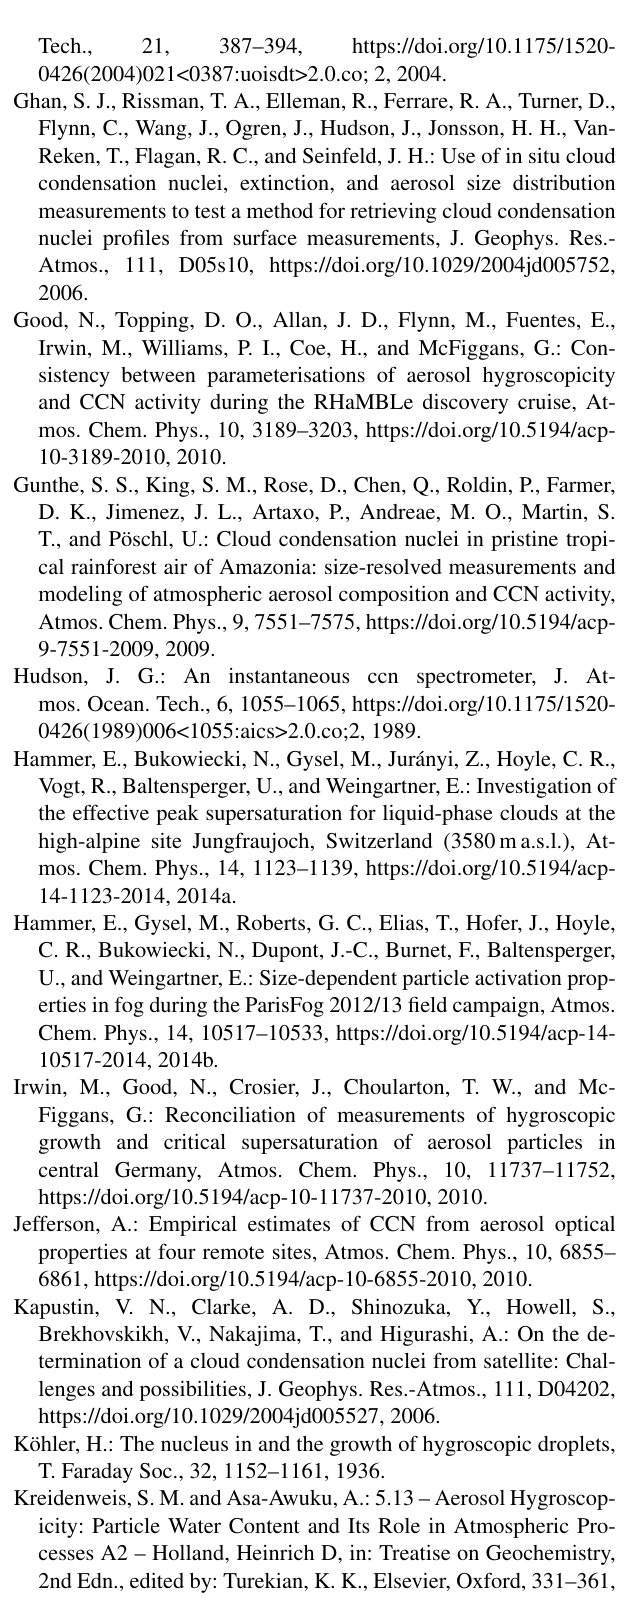
Figgans, G.: Reconciliation of measurements of